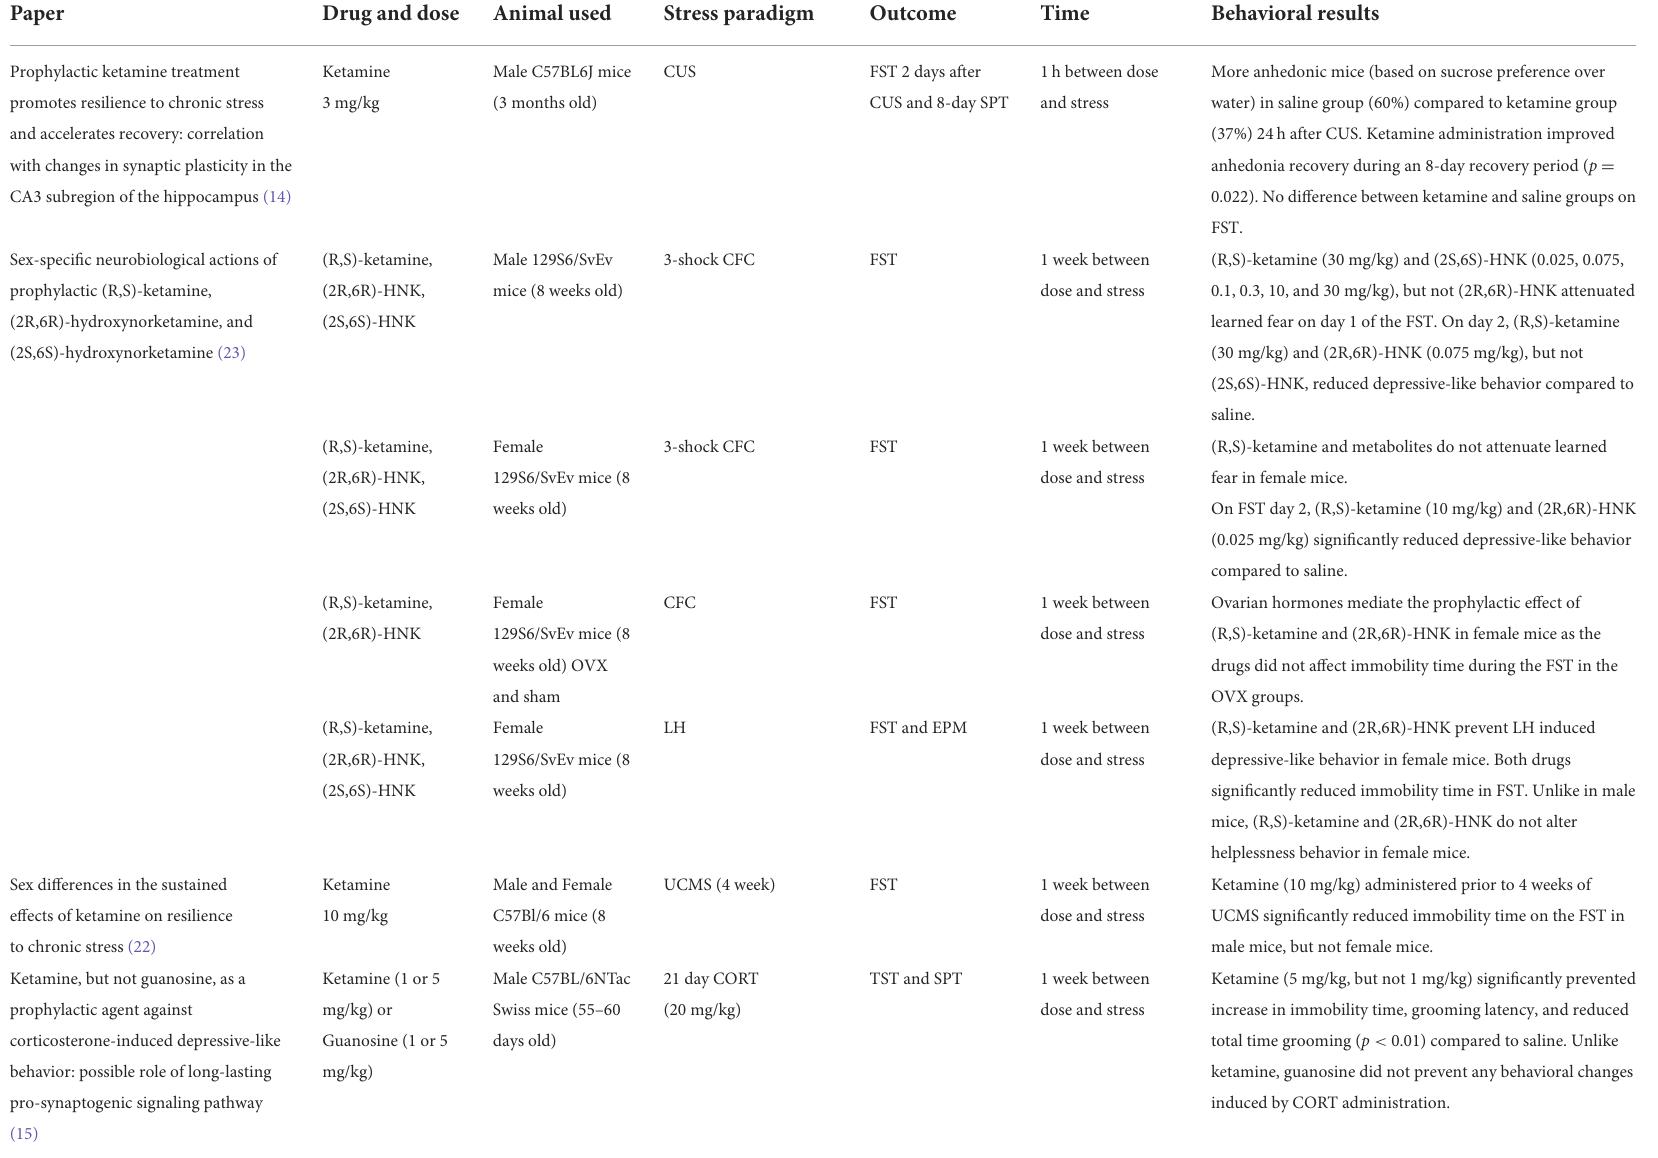
Ketamine (10 mg/kg) administered prior to 4 weeks dose and stress